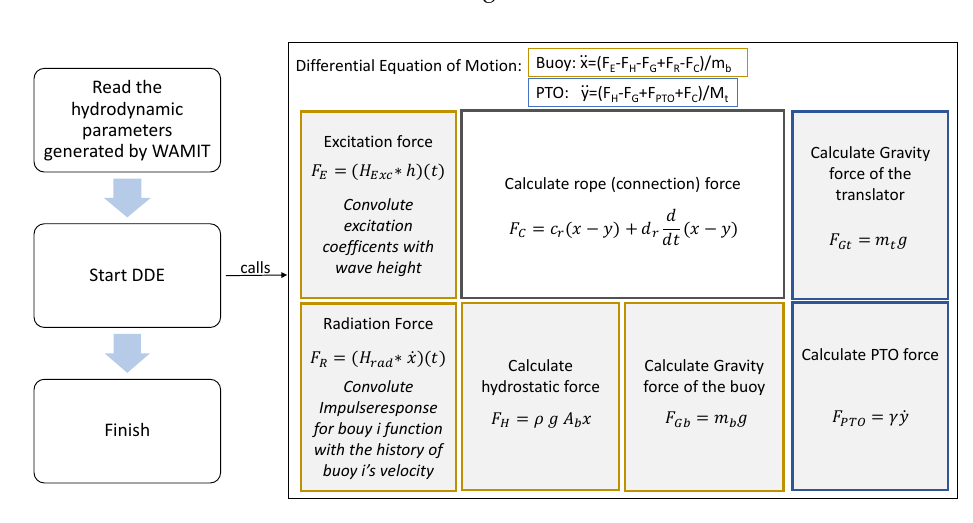
Figure 7. Diagram of the numerical